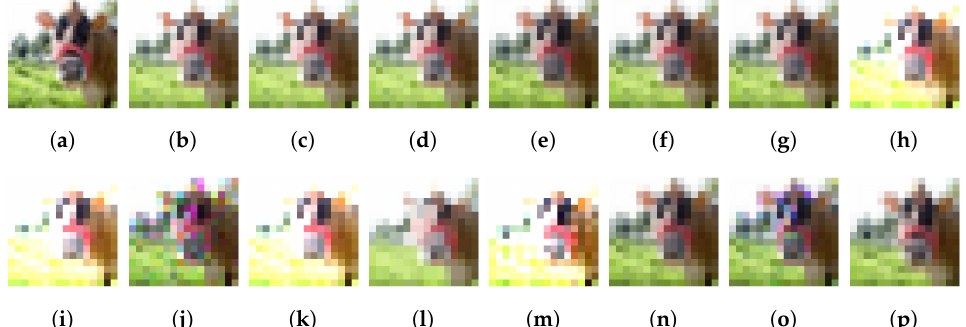
Figure 9. The CIFAR100 horse original image ( a ) and the respective results of the first pass of pooling for the methods Max ( b ), adaptive Max ( c ), fractional ( d ), Average ( e ), mixed ( f ), gated ( g ), tree ( h ), l2 ( i ), stochastic ( j ), fuzzy ( k ), overlapping Max ( l ), spectral ( m ), wavelet ( n ), LIP ( o ) and SoftPool ( p